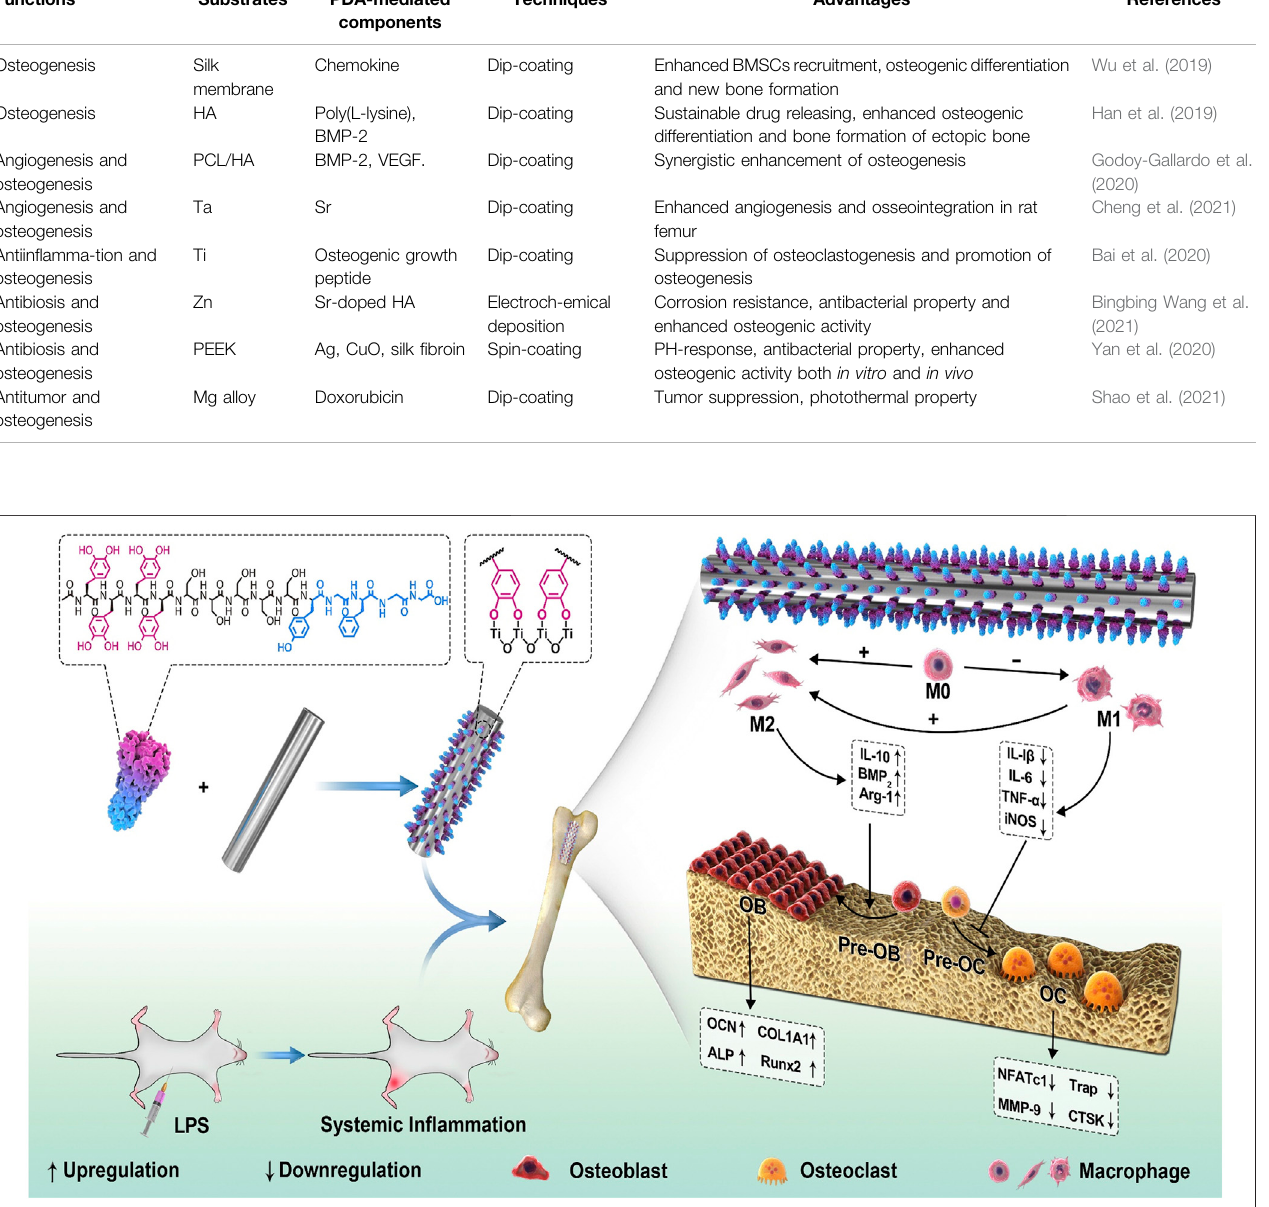
Frontiers in Bioengineering and Biotechnology |